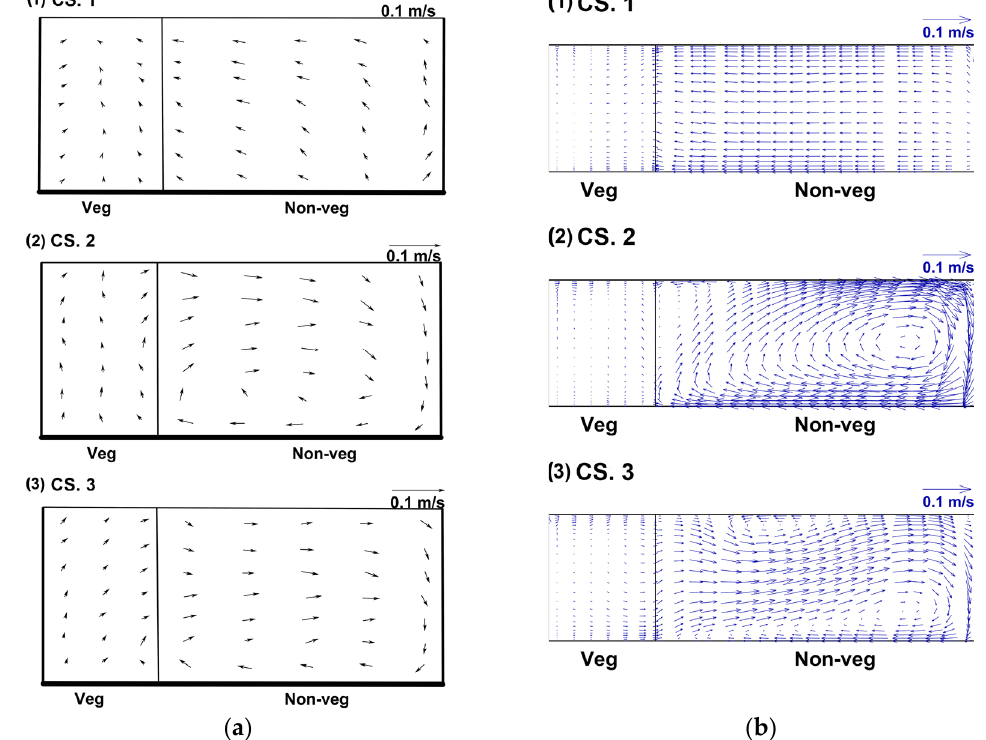
Figure 4. Comparison of secondary flow structures between the experimental data and simulation results on the test cross-sections: ( a ) Secondary flow vectors on the three test cross-sections of experimental data; ( b ) Secondary flow vectors on the three test cross-sections of simulation results. Table 2. RMSE and R 2 values of mean streamwise velocities on the three cross-sections. Section